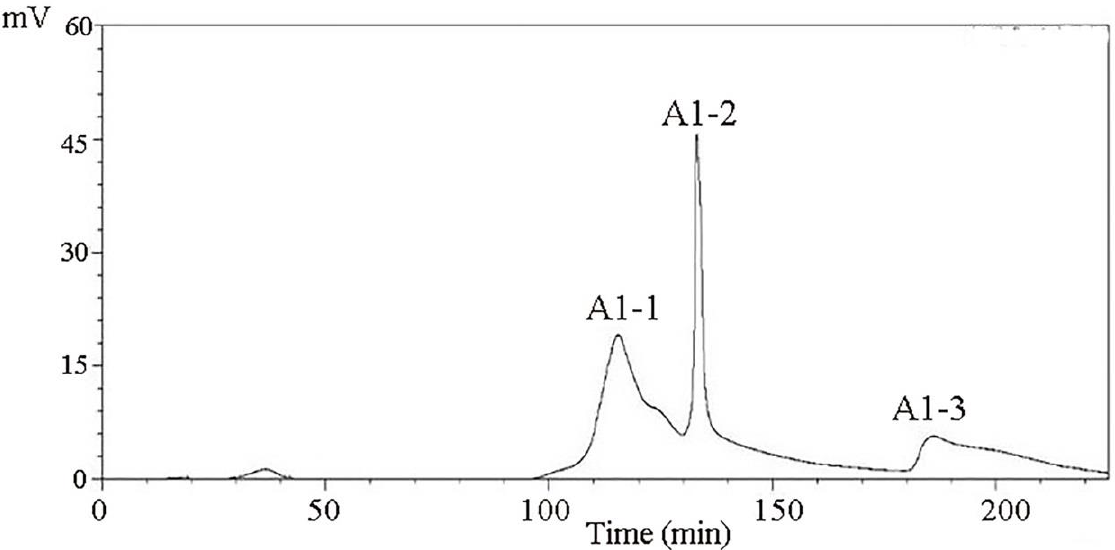
Figure 3. Purification spectra of peptides from Camella vietnamensis meal by Sephadex